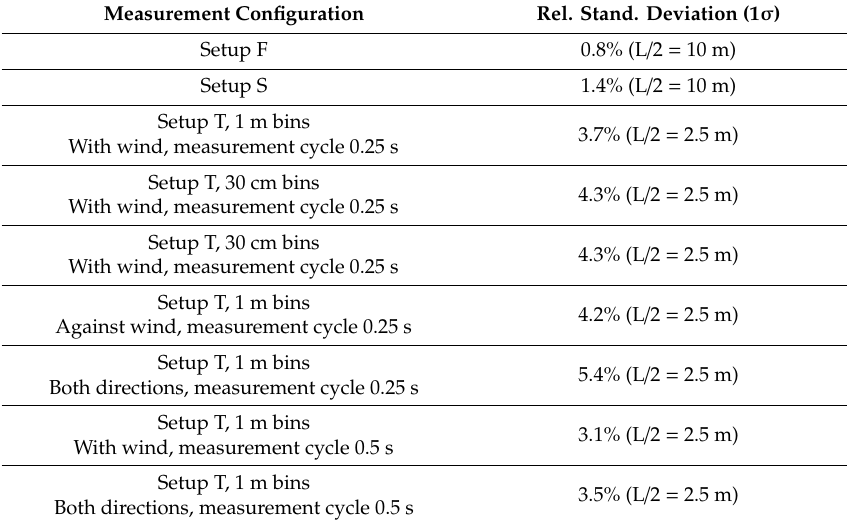
Table 2. Summary of relative standard deviations for di ff erent measurement setups arithmetically averaged from 40 measurement positions for the most a ff ected electrode layout (L / 2 (m), see Table 1). Additionalaspectssuchasthebinsize, thetowingdirectiondependingonthewindandthemeasurement cycle length are listed.